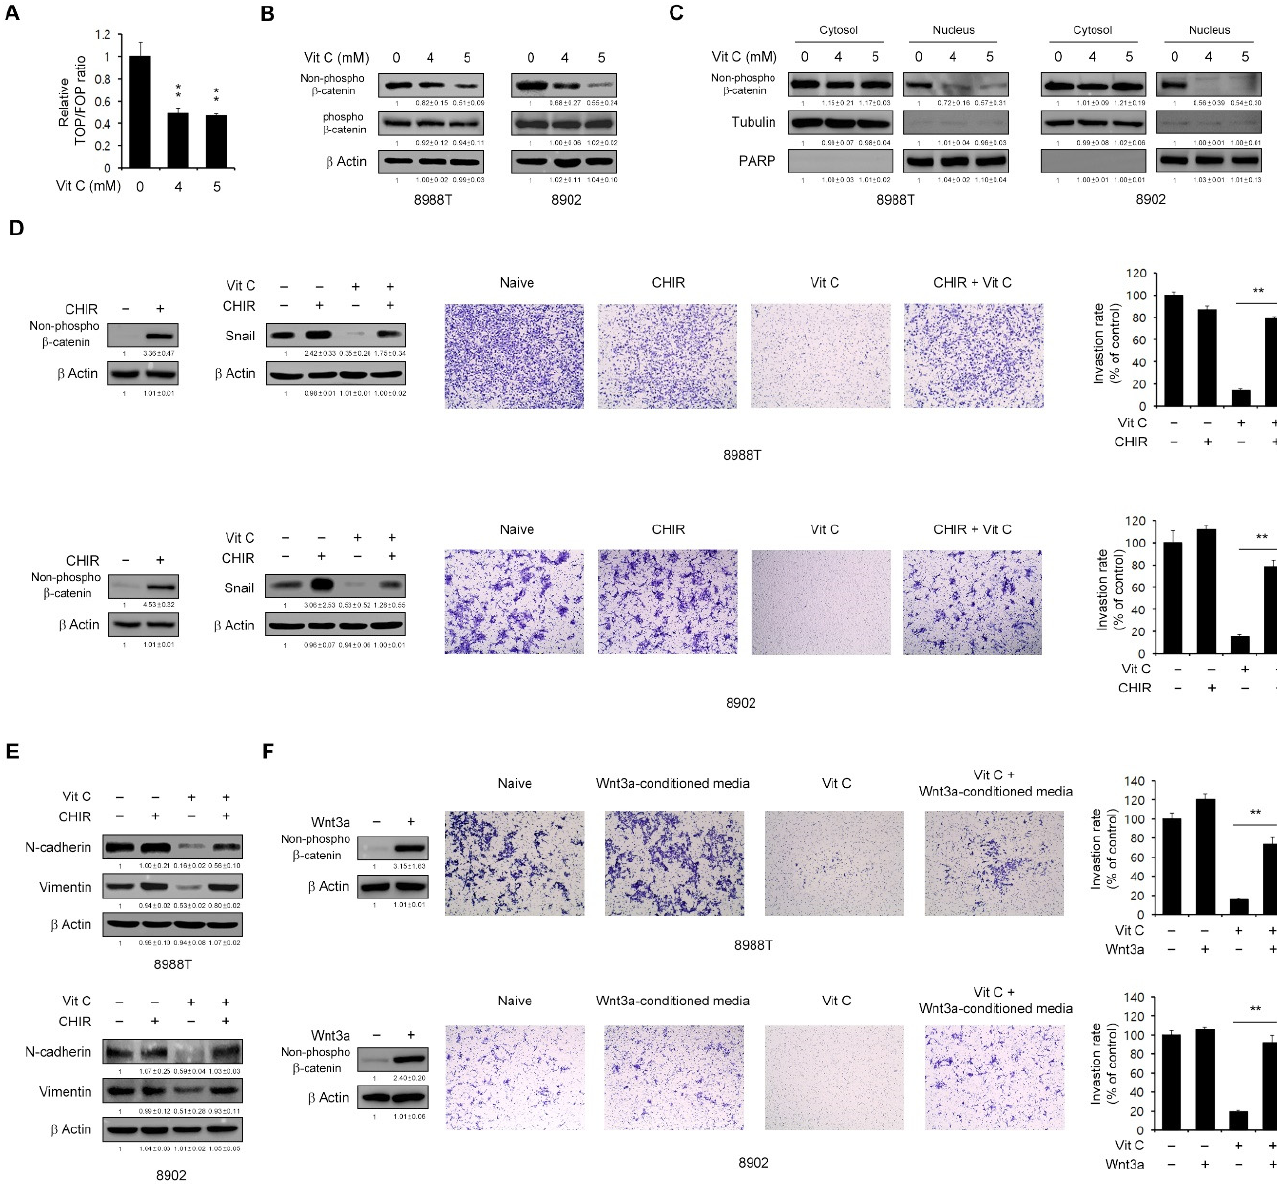
Figure 5. Effects of vitamin C on the migration ability of PDAC cells. ( A ) TOP/FOP luciferase reporter assays of 8988T cells treated with vitamin C (4 or 5 mM) for 24 h. ( B , C ) PDAC cells were treated with vitamin C (4 or 5 mM) for 24 h and immunoblotted with the indicated antibodies. Error bars reflect the s.d. of three independent experiments. ( D , E ) PDAC cells were treated with vitamin C (5 mM) for 24 h with or without CHIR and immunoblotted against the indicated antibodies. In- vasion assay for PDAC cells seeded into the upper chamber of a Matrigel (1 mg/mL) coated transwell and treated with vitamin C (5 mM) for 24 h in the lower chamber. The bar plot represents the percentage of cell invasion for each panel. ( F ) Invasion assay for PDAC cells seeded into the upper chamber of a Matrigel (1 mg/mL) coated transwell and treated with vitamin C (5 mM) for 24 h in the lower chamber. Error bars represent the s.d. of triplicate wells from a representative exper- iment among three independent experiments; ** p < 0.01. CHIR, CHIR99021.